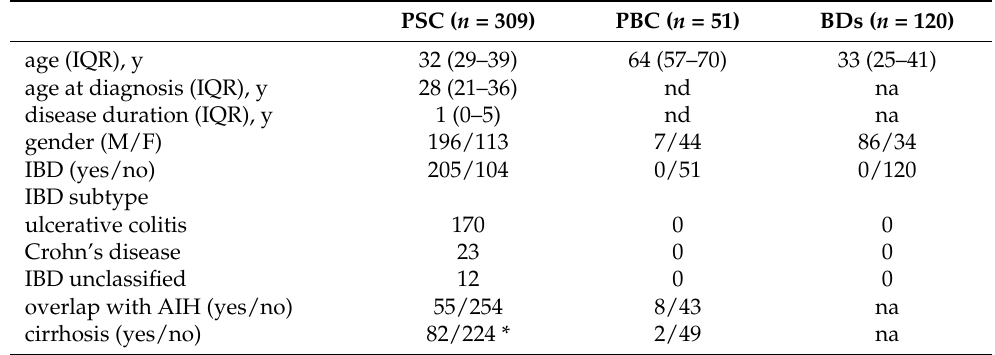
Table 1. Demographic and clinical data of the study cohorts. Abbreviations: autoimmune hepatitis, AIH; blood donors, BDs; female, F; inflammatory bowel disease, IBD; primary biliary cholangitis, PBC; male, M; primary sclerosing cholangitis, PSC; years,